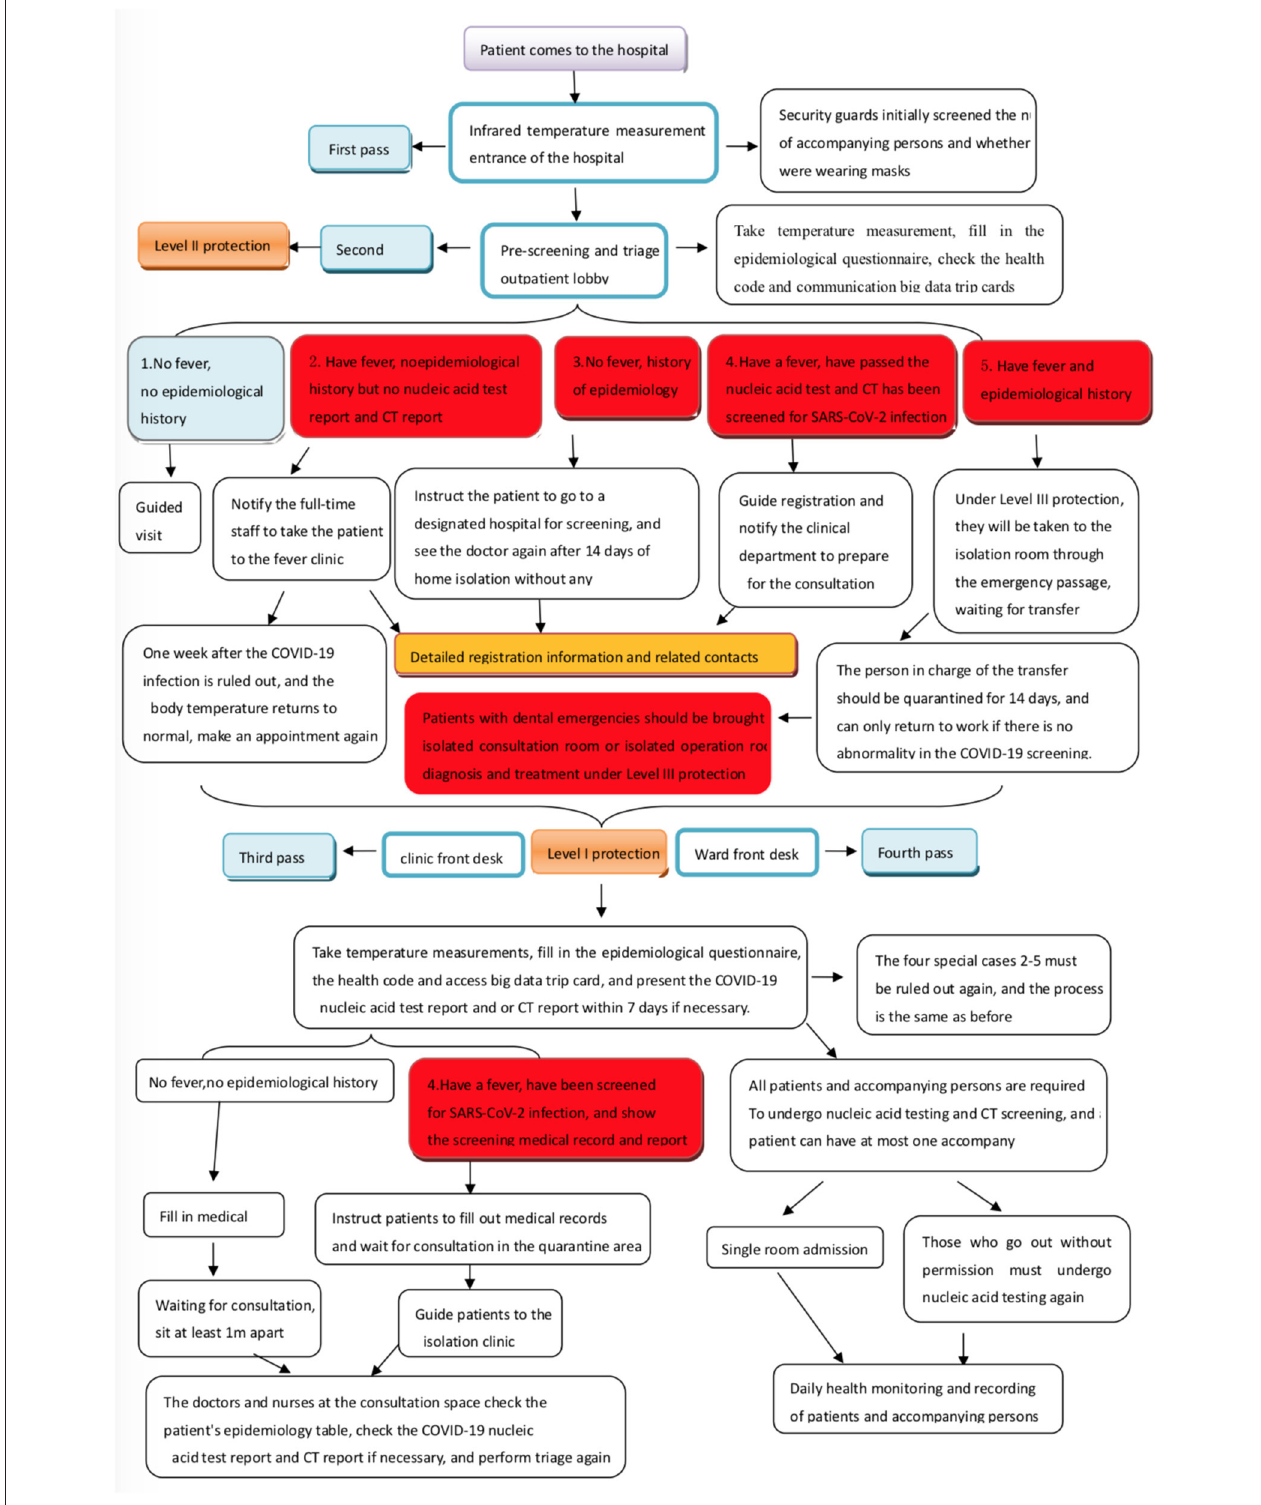
FIGURE 1 | Pre-screening and triage process in dental institutions during the coronavirus disease 2019 (COVID-19) pandemic.